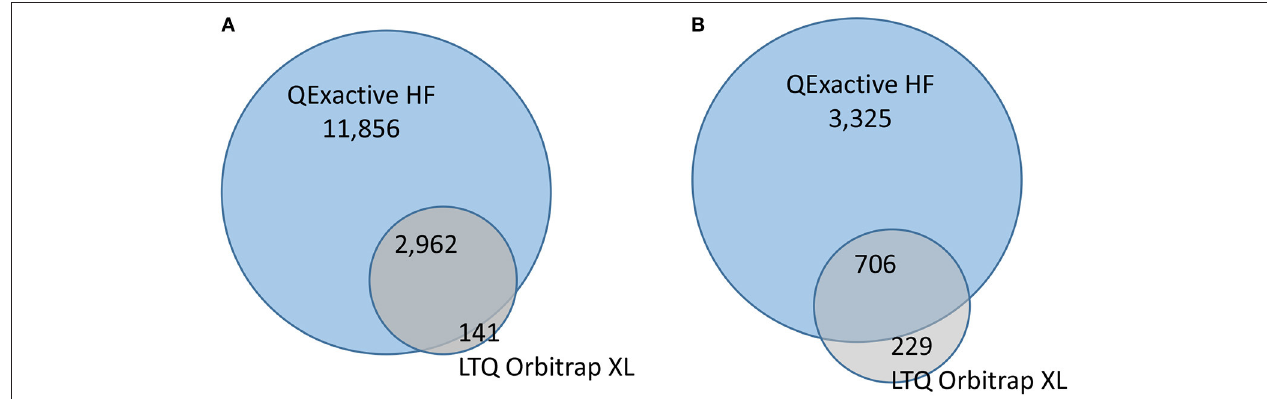
FIGURE 1 | Peptides and proteins identified by the two mass spectrometry platforms. (A) . Numbers of peptide sequence-spectrum matches. (B) Numbers of proteins identified by at least 2 peptide sequences.